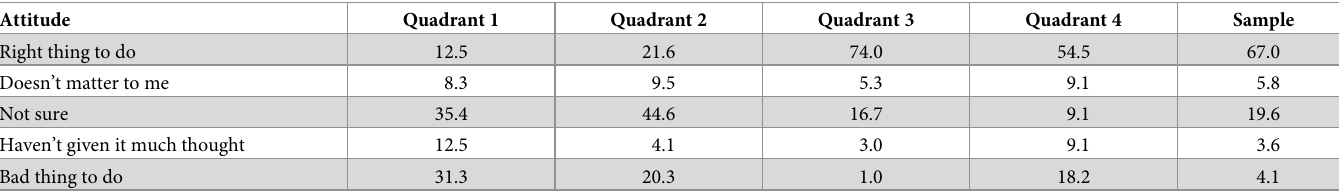
Table 3. I 3 vaccine classification and attitude towards being vaccinated.